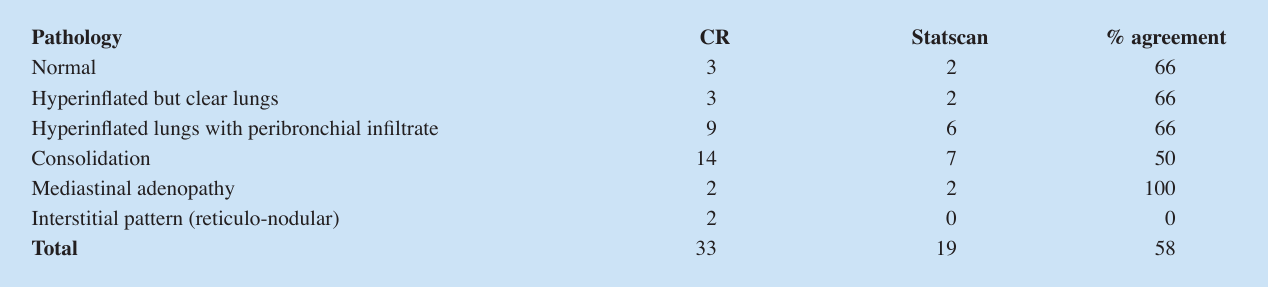
Table III. Percentage agreement for diagnostic capabilities between the two modalities